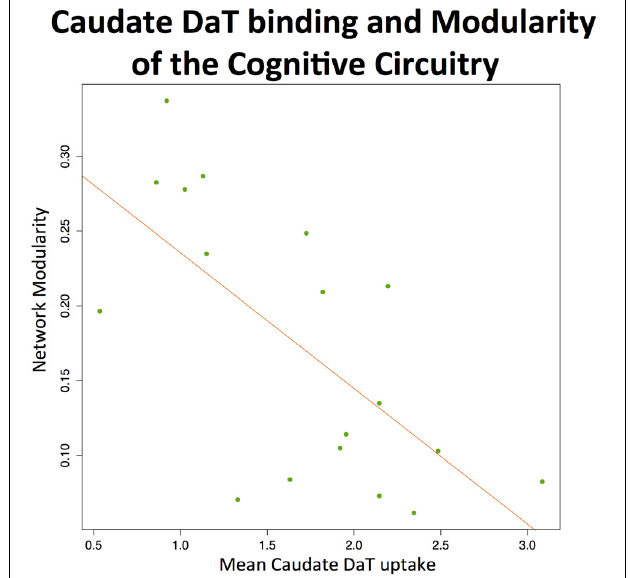
FIGURE 3 | Caudate DaT uptake and modularity of the cognitive circuitry at rest. The figure shows significant ( p < 0 . 01) negative association between modularity of the cognitive circuitry (identified with automated meta-analysis) and nigrostriatal dopaminergic function measured by 123 I-FP-CIT SPECT (mean caudate SBR